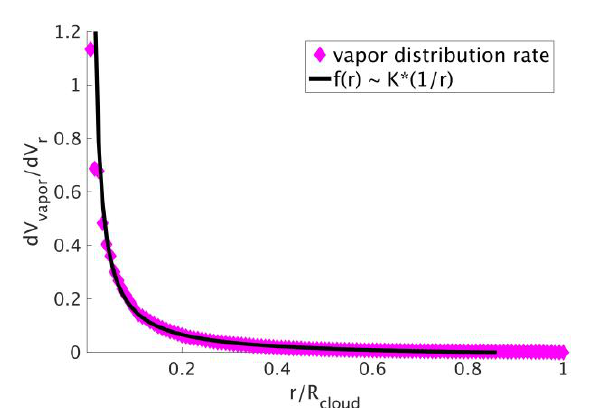
Fig. 2: Random distribution of spherical bubbles within the small computational domain